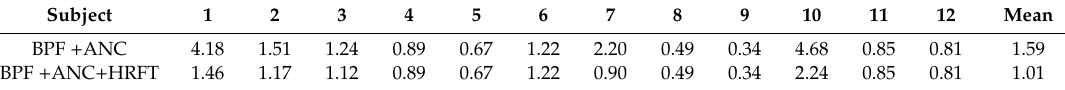
Figure 3. Flowchart of heart rate frequency tracking Table 2. Results of HR AAE before and after applying the heart rate frequency tracking (HRFT) stage.